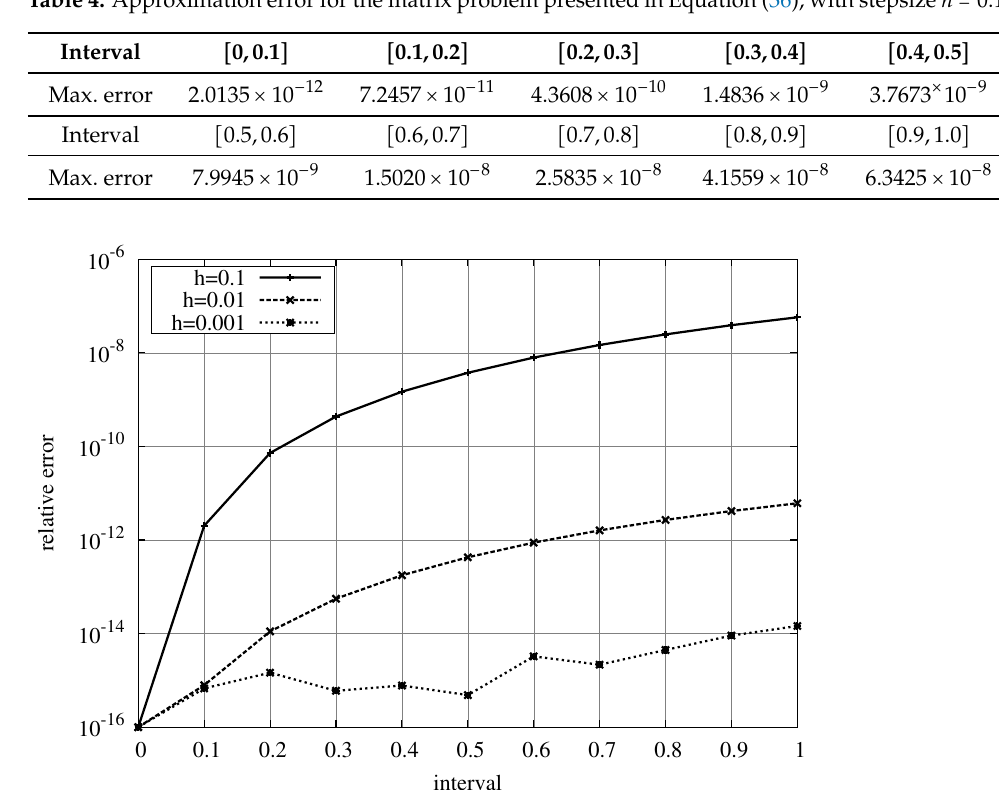
Table 4. Approximation error for the matrix problem presented in Equation (36), with stepsize h